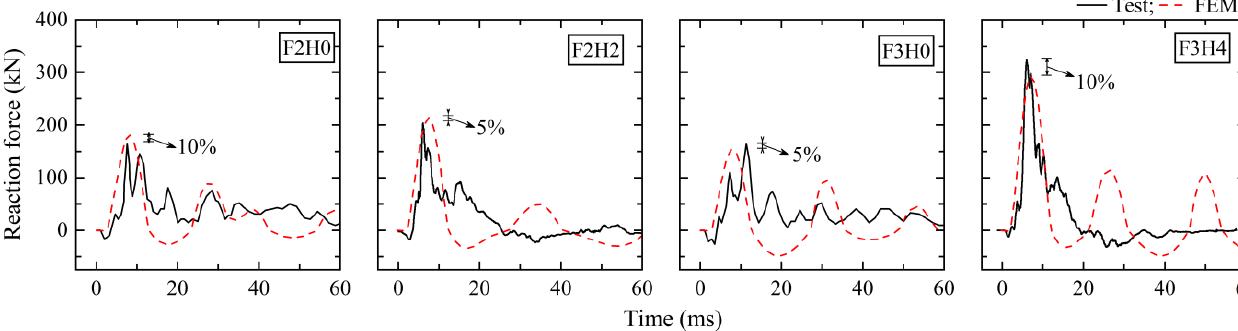
Figure 3. Comparison of reaction force of fixed-hinged columns.